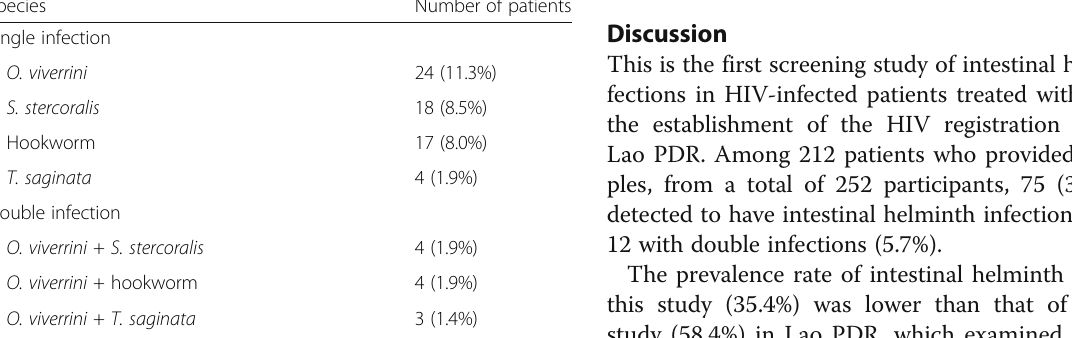
Table 3 The overall results of detected helminth infections among 212 HIV-infected patients Species